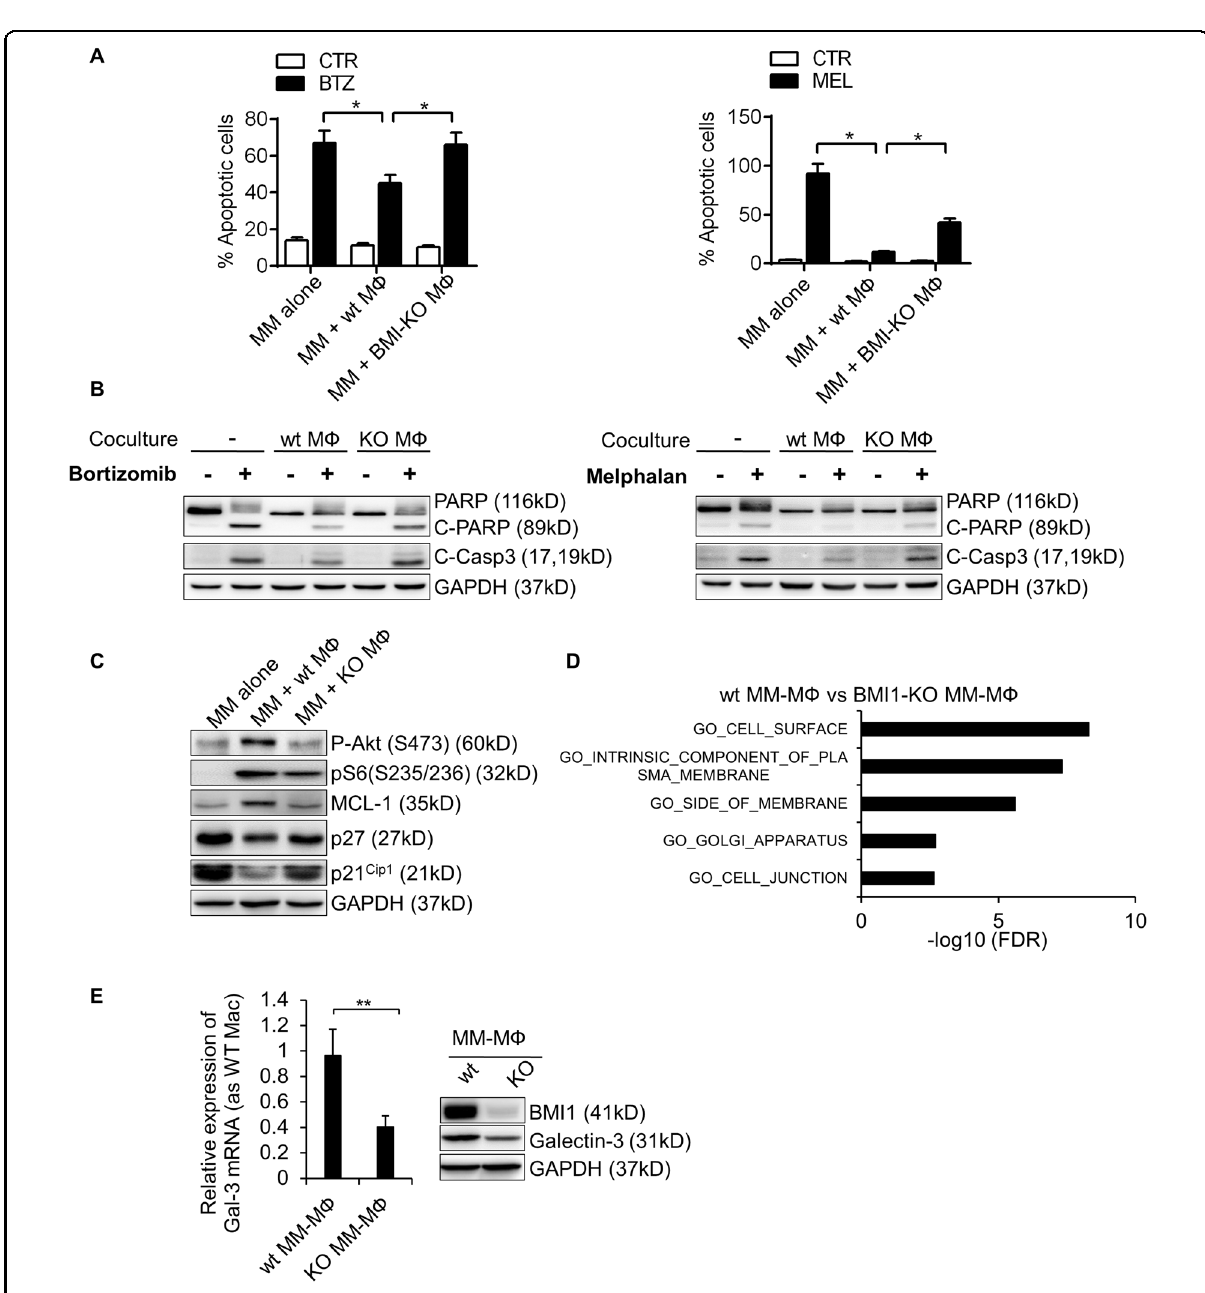
Fig. 6 MM-M Φ s-conferred myeloma chemoresistance requires BMI1 overexpression. A The apoptotic rate of 5TMG1 cells treated with indicated drugs alone or with wt M Ф s or BMI1-KO M Ф s for 24 h. Statistical signi fi cance was determined by two-tailed Student t -test between drug treated 5TGM1 cells cultured alone and with wt MM-M Ф s, or between drug treated 5TGM1 cells cultured with wt MM-M Ф s and with BMI1-KO MM- M Ф s, * P < 0.05. B Western blot showed the activation status of apoptotic protein PARP and Capase-3 of 5TGM1 cells treated with indicated drugs alone or with wt or BMI1-KO M Ф s for 24 h. C Western blot showed the protein expression or phosphorylation changes of 5TGM1 cells cultured alone or with wt or BMI1-KO M Ф s. D Pathway enrichment of differential regulated genes from RNA-seq data of wt vs BMI1-KO MM-M Ф s, comparing with GO cellular component genesets. E RT-qPCR showed the mRNA expression of Galectin-3 was decreased in BMI1-KO MM-M Ф s, relative to wt MM-M Φ s (left column). Western blot showed the protein level of Galectin-3 was lower in BMI1-KO MM-M Ф s (right panel). Statistical signi fi cance was determined by two-tailed Student t -test between wt and BMI1-KO MM-M Ф s, ** P <